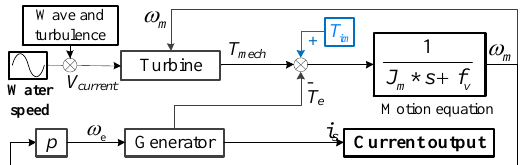
Figure 1. Energy transfer mechanism of MCT.